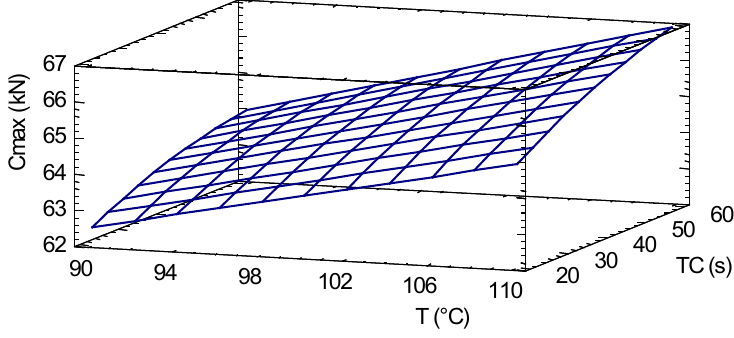
Figure 7. Estimated response surface for maximum compressive strength considering the process temperature and compaction time for a rice husk ratio of 50%.